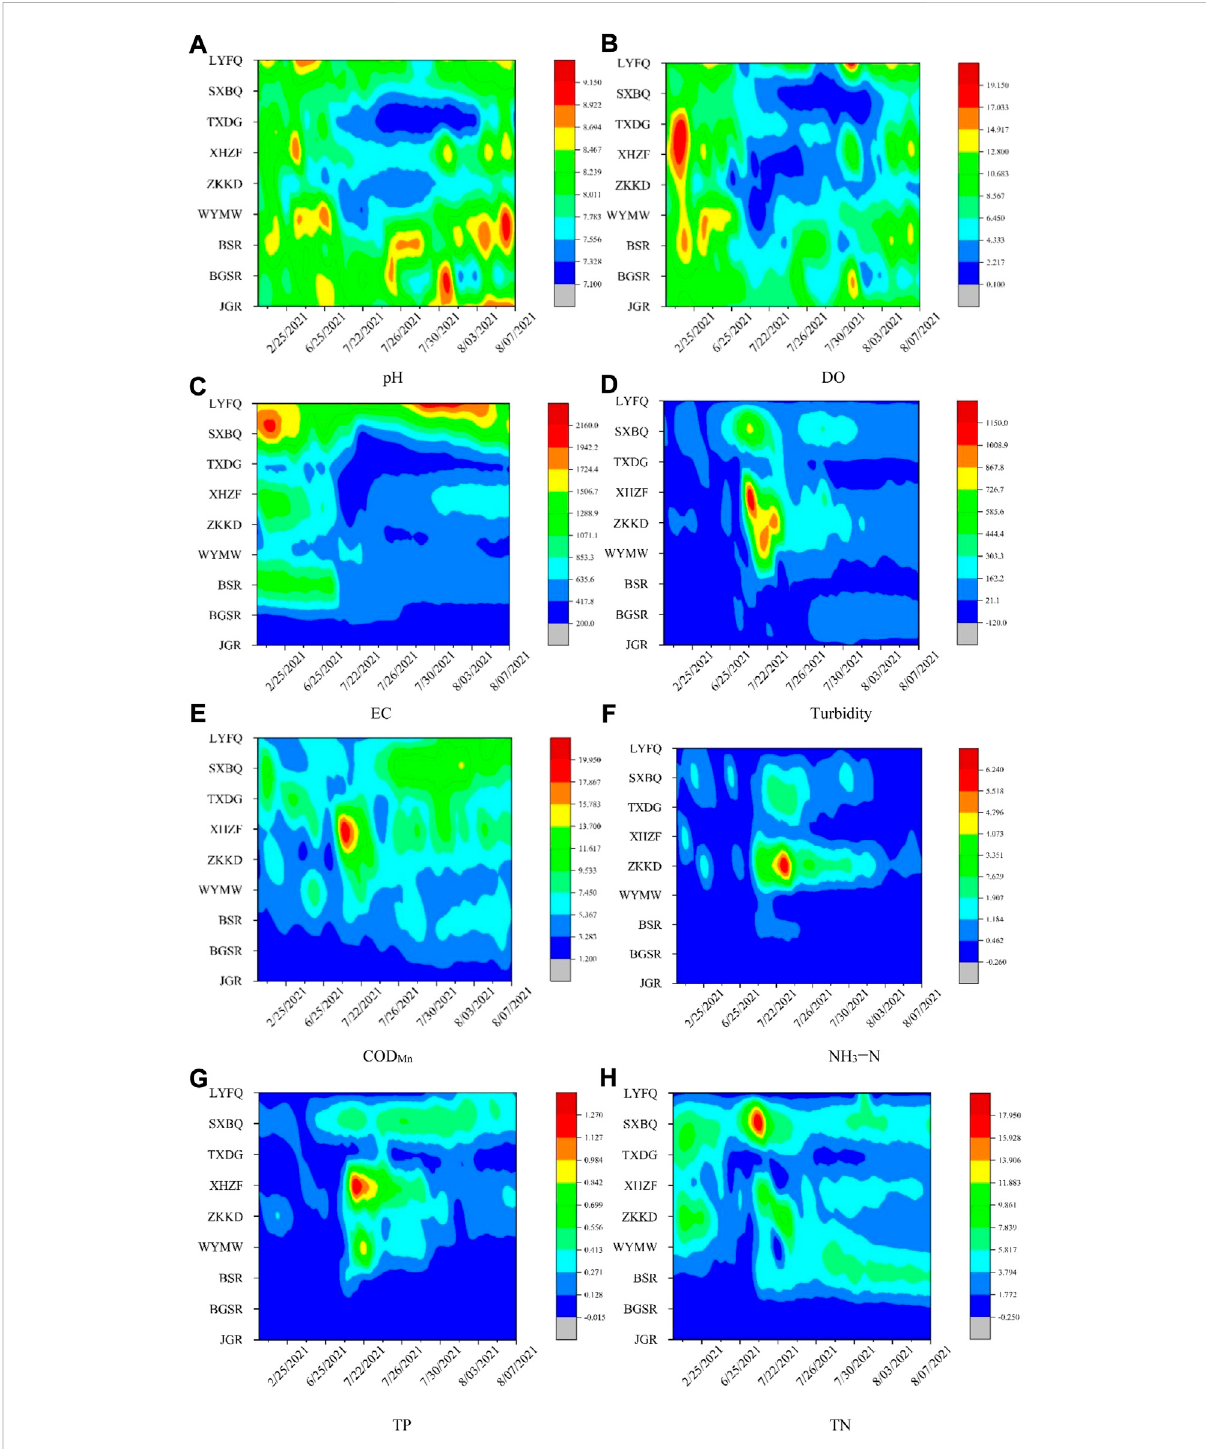
FIGURE 5 ThechangeprocessofthepH (A) , DO (B) , EC (C) ,Turbidity (D) ,COD Mn (E) ,NH 3 − N (F) ,TP (G) ,andTN (H) atdifferentmonitoring stationsbefore and after the rainstorm. The heat maps show the trend of water quality indicators at each monitoring station before and after the rainstorm, which could intuitively see the time for each water quality indicator to reach the maximum or minimum